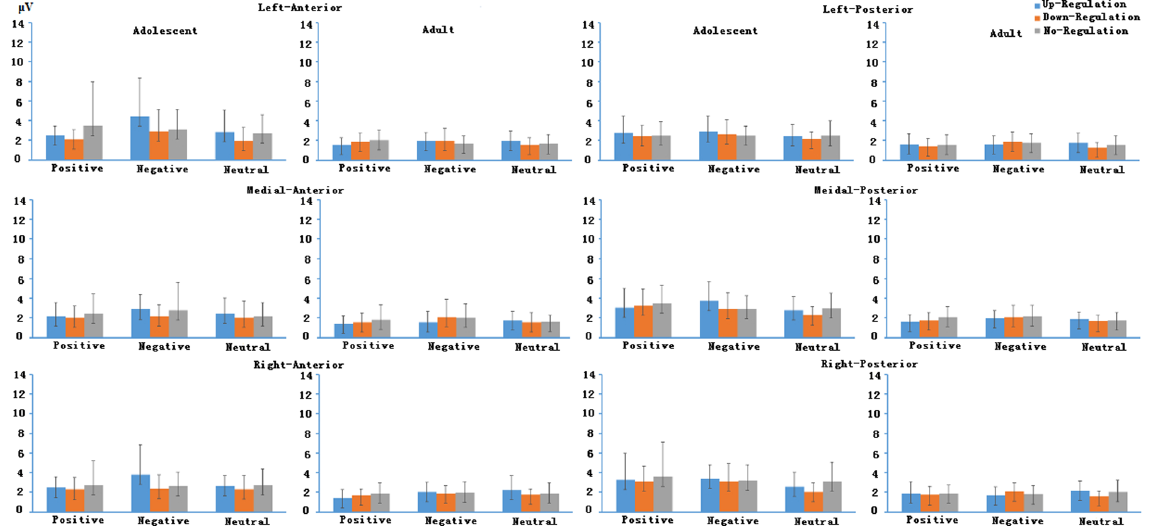
Figure 6. LPP averages in late time windows in different experimental conditions between adolescents and